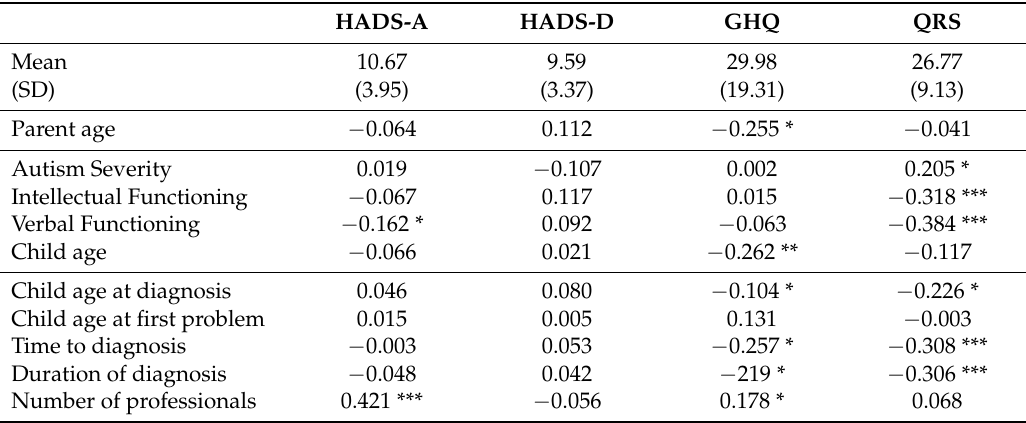
Table 3. Means (standard deviations for the parents self-reports of health, and the Pearson correlations between parent, child, and diagnostic factors and parents’ self-reports of health (HADS-A = anxiety; HADS-D = depression; GHQ = health relayed quality of life; QRS = parenting stress).